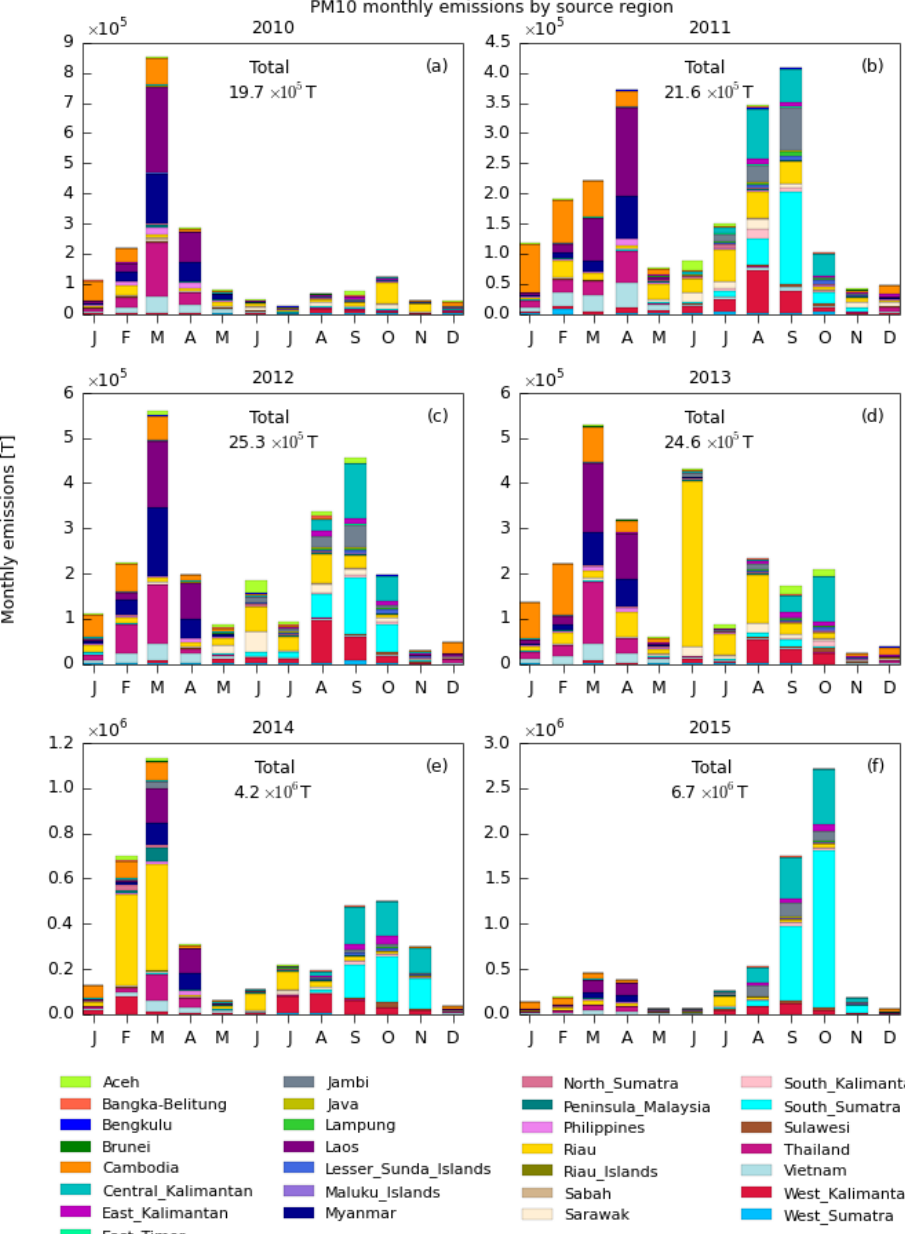
Figure 3. Regional PM 10 biomass burning emissions, calculated based on GFAS fire radiative power and injection height and emission factors described in Sect. 2, for each of the six years from 2010 to 2015, summed over each month. Colours for each source region for all years are listed below the plots. Note the different scales on the y axis (units: tonnes emitted per